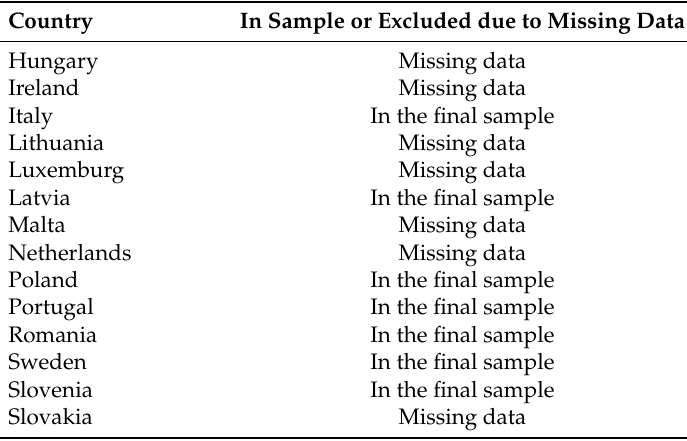
Table A2. Cont. Country In Sample or Excluded due to Missing Data Missing